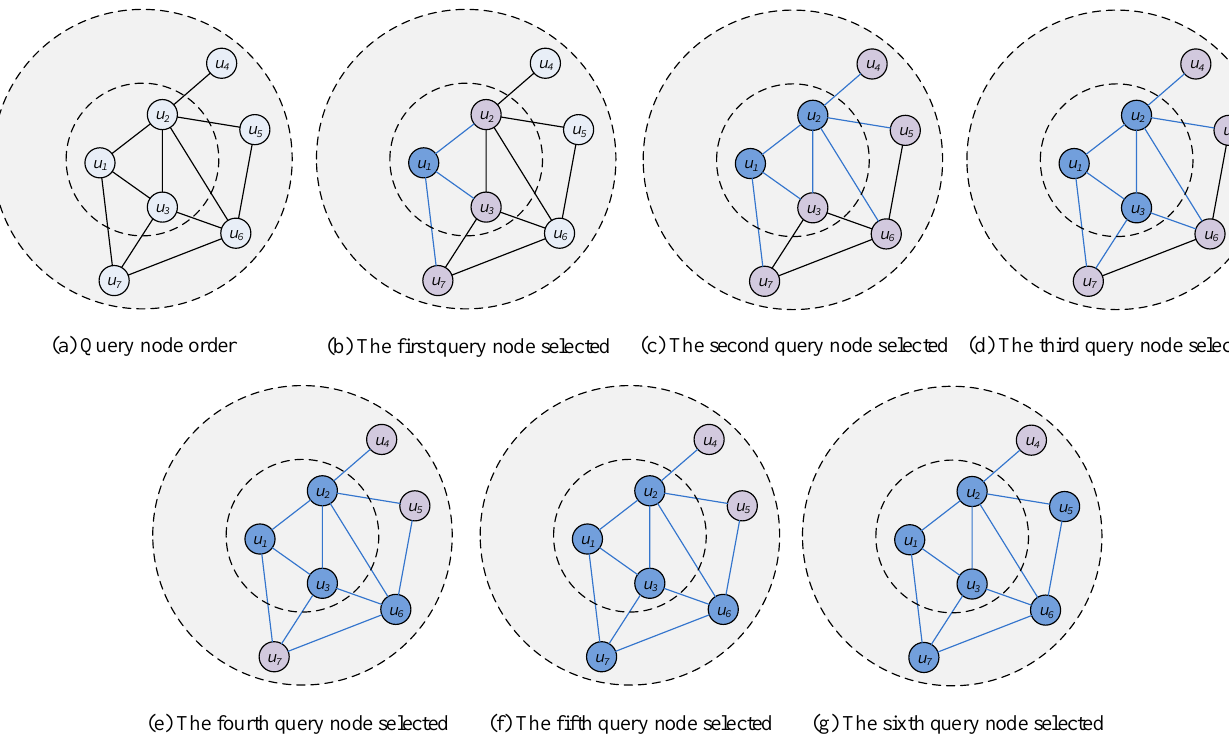
Figure 8. Query node selection order.